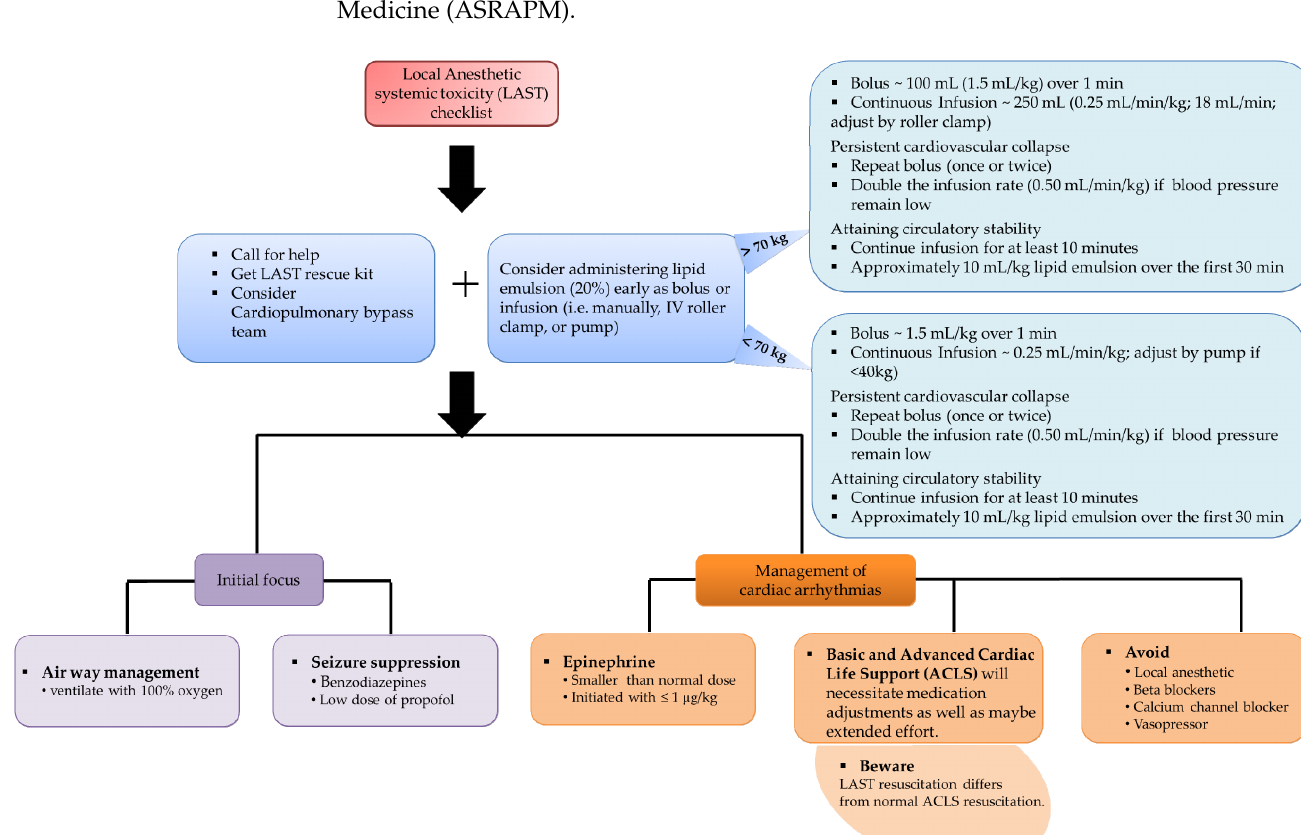
Figure 3. The American Society of Regional Anesthesia and Pain Medicine (ASRAPM) guidelines for the management of local anesthetic systemic toxicity (LAST) [59,60] .